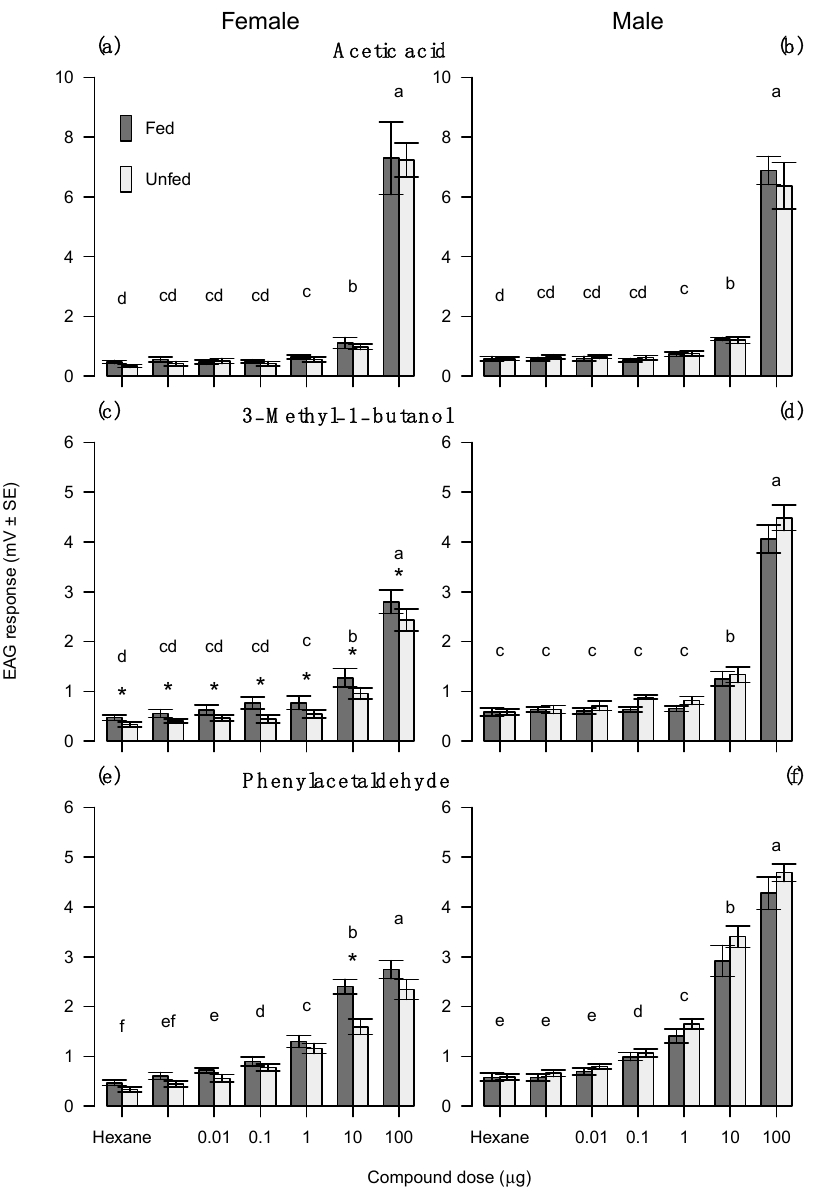
Figure 5. Experiment 6—Average antennal response (mV ± SE) of female ( a , c , e ) and male ( b , d , f ) redbacked cutworm moth antennae to feeding attractant volatiles: acetic acid ( a , b ), 3-methyl-1-butanol ( c , d ) and phenylacetaldehyde ( e , f ). Means comparisons were conducted among dose within sex and chemical compound. Bars marked with different letters within each panel are statistically different (Tukey method, α = 0.05). Significant difference between antennal response of fed or unfed moths within dose and chemical compound is represented by (*) (Tukey α = 0.05).